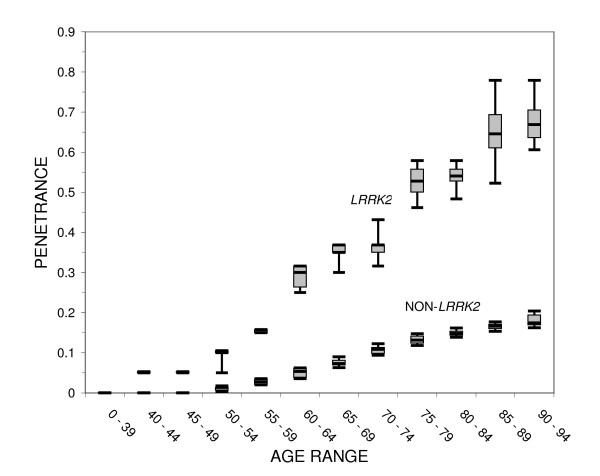
The box plot shows the median and 25th and 75th percentiles with whiskers extending to the 5th and 95th percentiles of the penetrance at each age range for G2019S carriers and for non-LRRK2 carriers among families recruited for at least two Parkinson's disease-affected siblings.